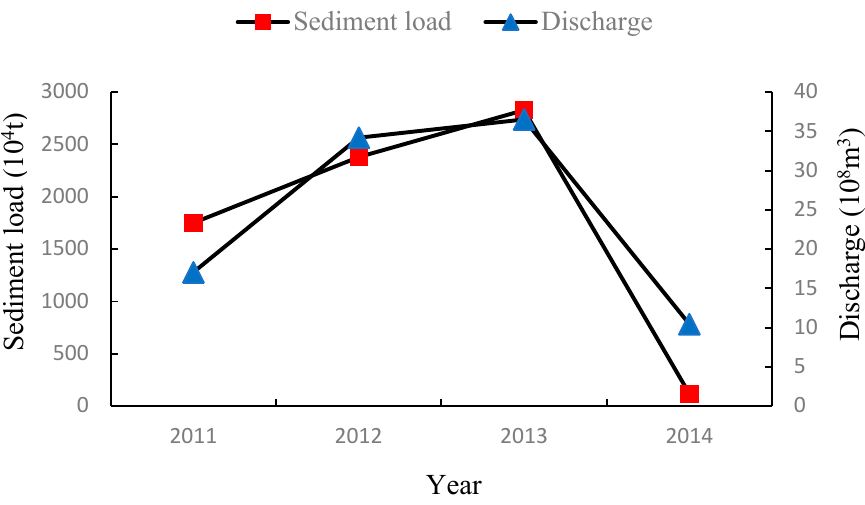
Figure 2. Interannual variation of freshwater discharge and sediment load at Lijin station.